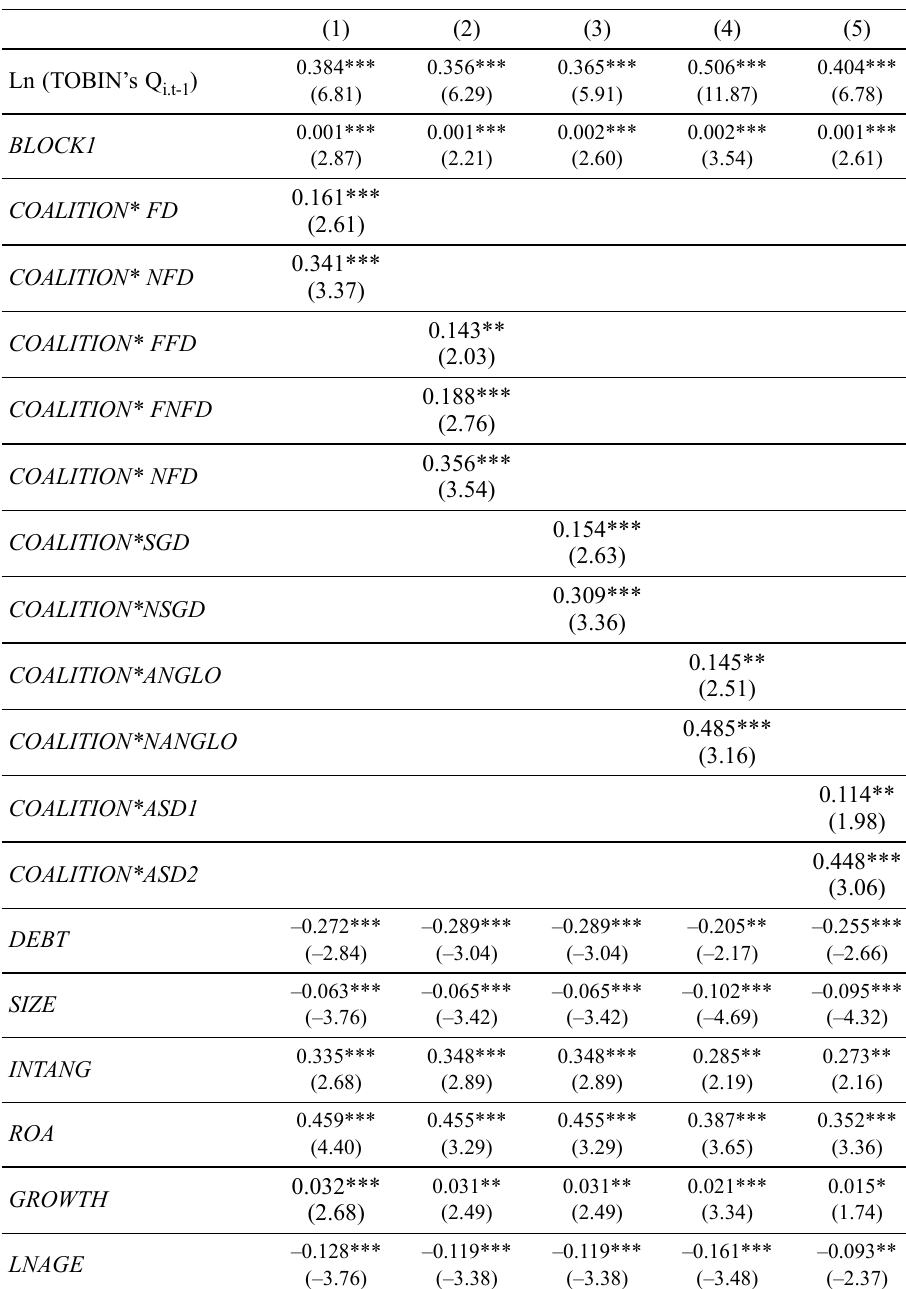
Table 5. Relation between firm value and the contestability effect. The moderating role of identity and the institutional